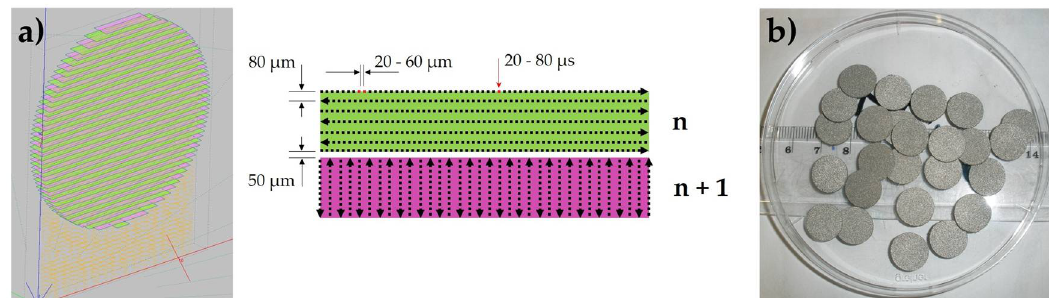
Figure 9. Samples orientation and scanning strategy ( a ), “as-made” samples after cleaning ( b ).